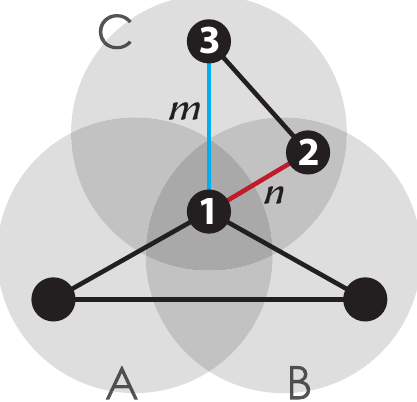
Figure 2. Ambiguous edges among three